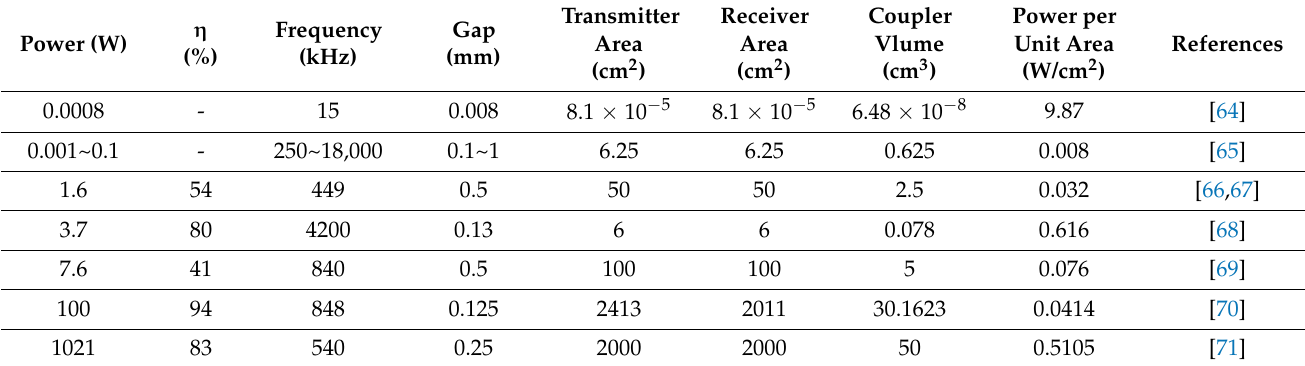
Table 2. Capacitive Power Transfer (CPT).